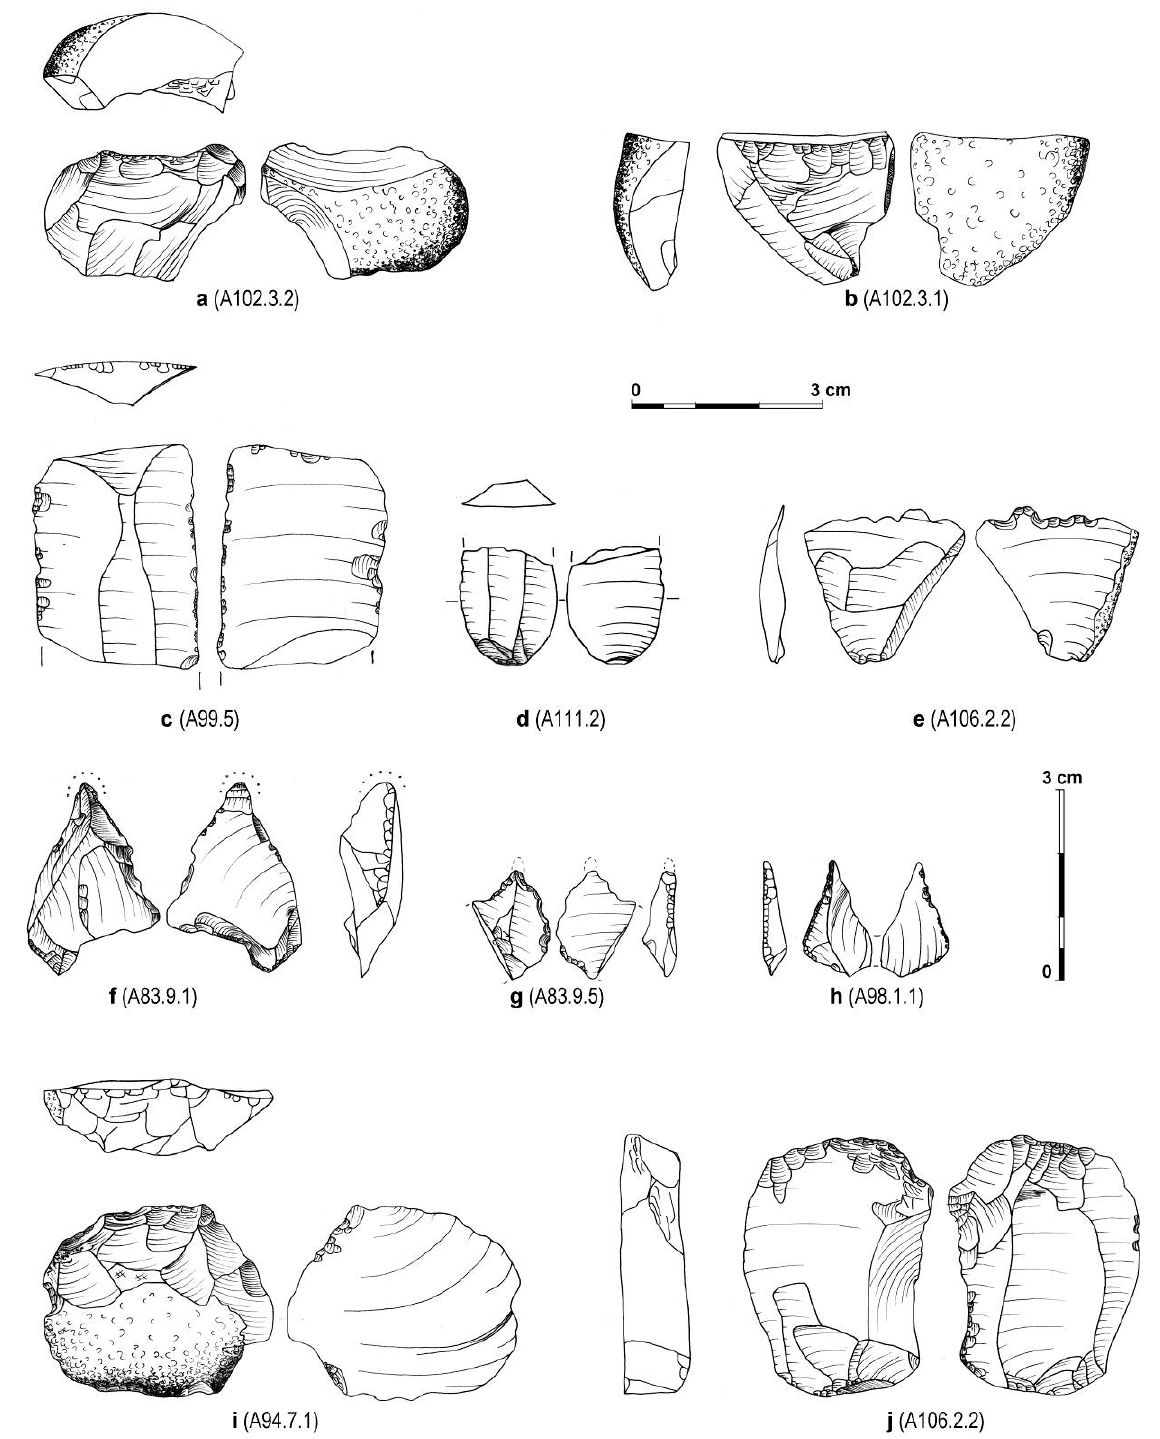
Figure 5. Lithic artefacts from KS A: a-b: flake cores; c-d: chert blade segments; e: denticulated flake; f: drill; g- h: microborer; i: scraping tool; j: piéce esquillée ; chert (c-d) and obsidian (a-b, e-j) (drawings by C.